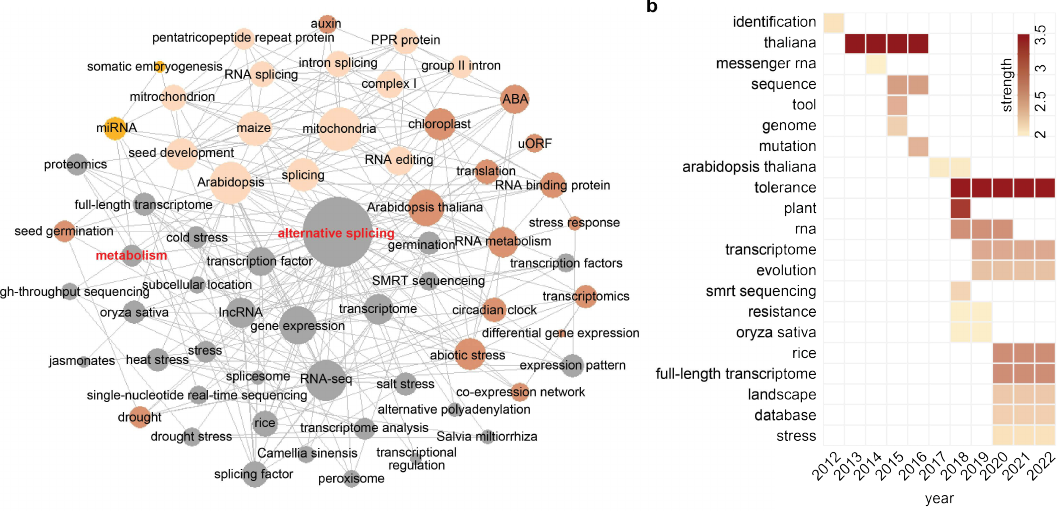
Figure 1. Analysis of keywords in Web of Science Core Collection database from January 2012 to May 2022. ( a ) Keyword co-occurrence network analyzed by BibExcel and Pajek. Nodes represent keywords. Node size represents the frequency of keywords that appear. Node colors represent modularity. ( b ) Burst keyword analysis. Length of colored boxes represents burst status duration. Colors represent burst strength. Bibliometric analysis was carried out by retrieving citation data on topic search using query: “TS = (alternative splicing OR splicing factor) AND plant AND (metabolism OR metabolic OR metabolize)” and was further analyzed by CiteSpace (https://citespace.podia.com, accessed on 1 June